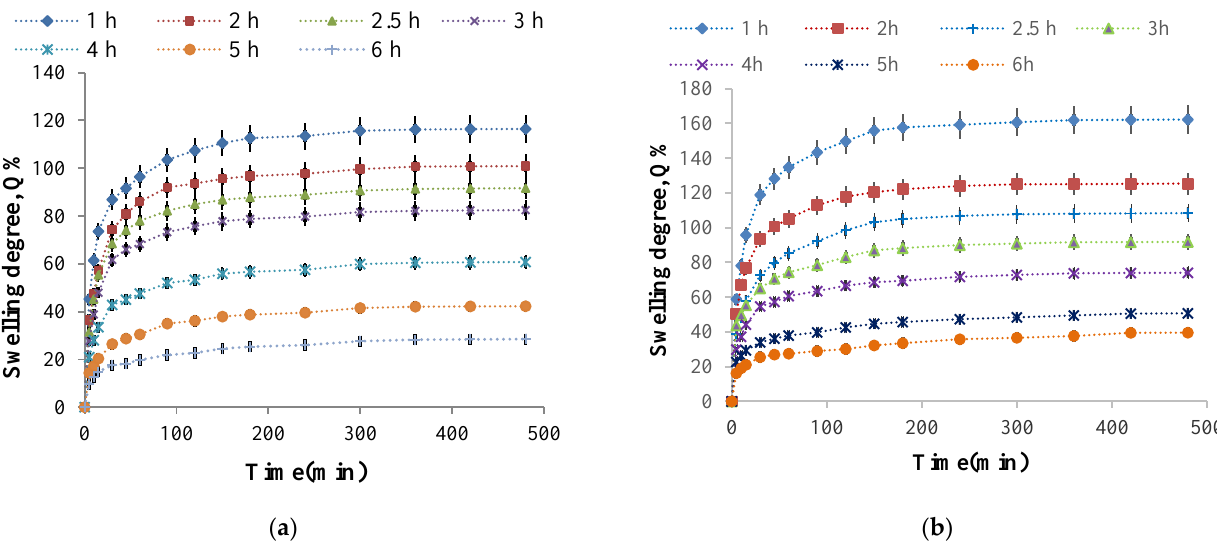
Figure 11. Variation in time of the swelling degree for P2 sample obtained at different cross-linking times in different pH solutions: ( a ) pH =5.5 and ( b ) pH = 7.4.